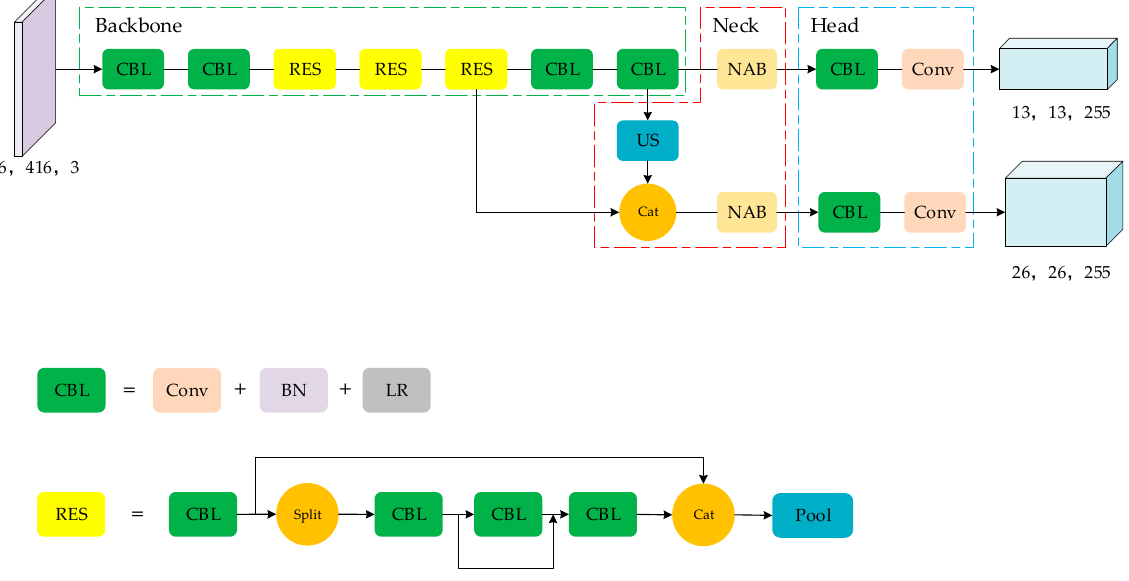
Figure 6. The network of the improved YOLOv4-Tiny. ‘Split’ is the operation that divides the feature map into two portions along the channel axis. ‘Pool’ denotes 2 × 2 max-pooling.